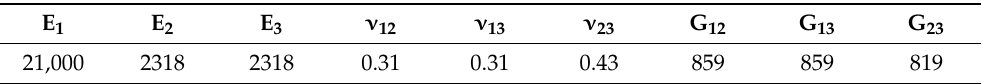
that of the laminated reference.